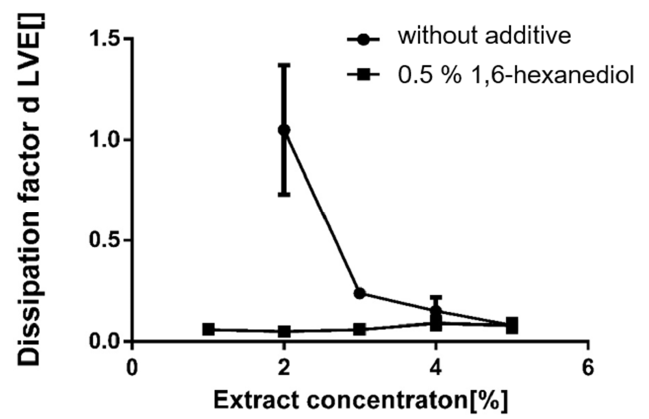
Figure 11. Dissipation factor d with di ff erent concentrations of TE with and without 1,6-hexanediol (0.5%); mean ± SD, n =